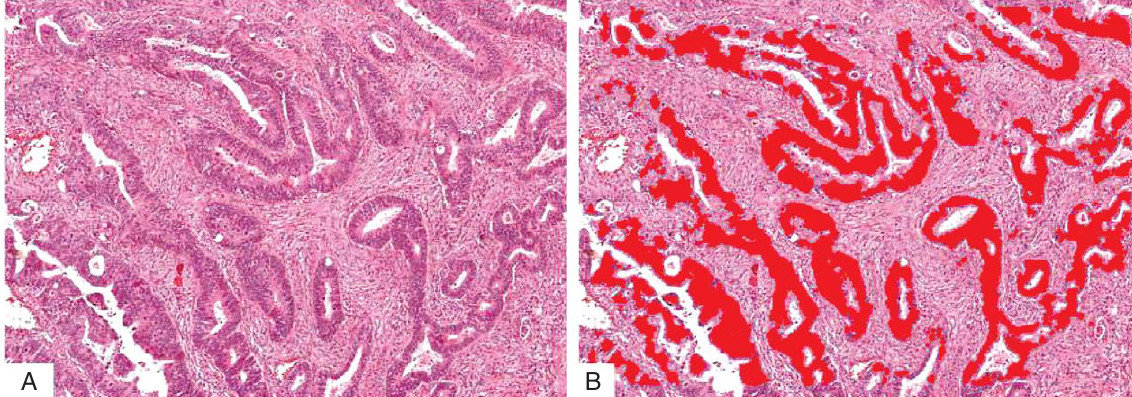
Fig. 5. Example of area estimation of colonic adenocarcinoma. Panel A is a 4 × magnification of an H&E tissue section. A ring vector was selected to “paint” the malignant glands and the area was calculated to be 0.39mm 2